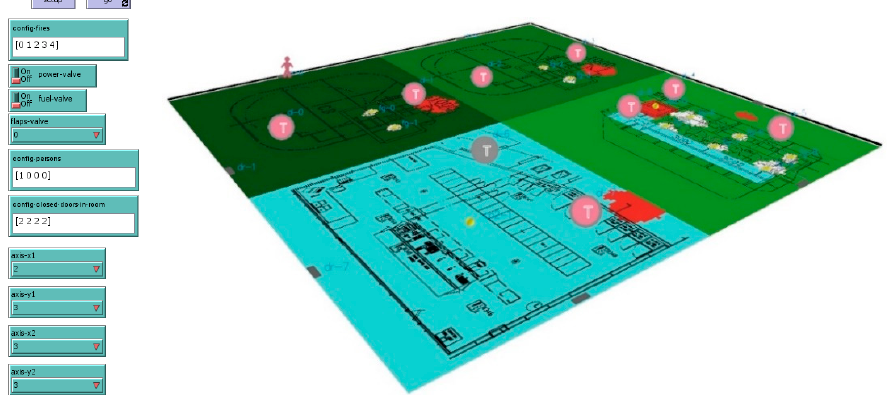
Figure 2. User interface of the developed system.